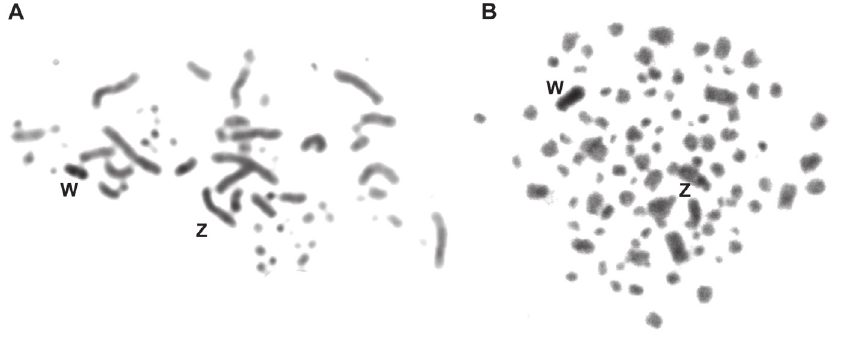
Figure 2. Comparative C-banding analysis of the Ringed Kingfisher Megaceryle torquata ( A ) and the Green Kingfisher Chloroceryle americana ( B ) . Table 1. Karyotype information’s in Alcedinidae